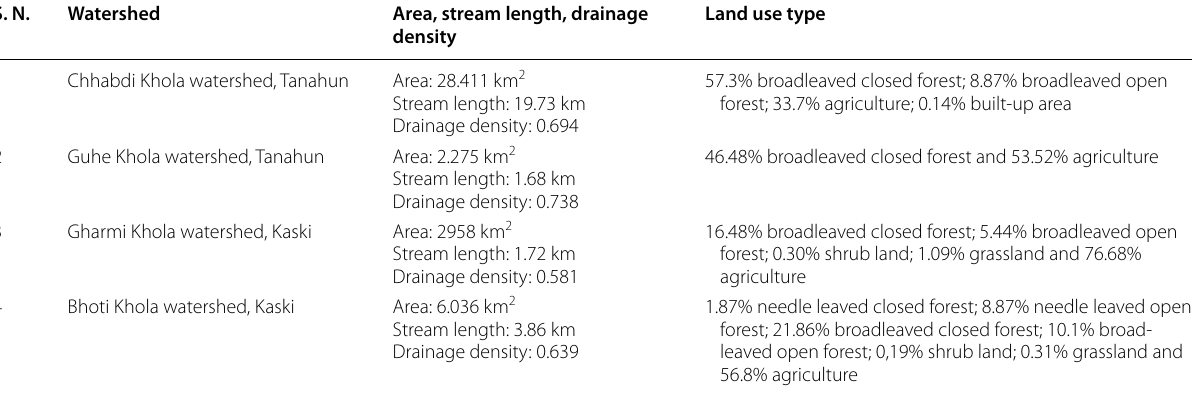
Table 3 Watershed-specific conditions S.